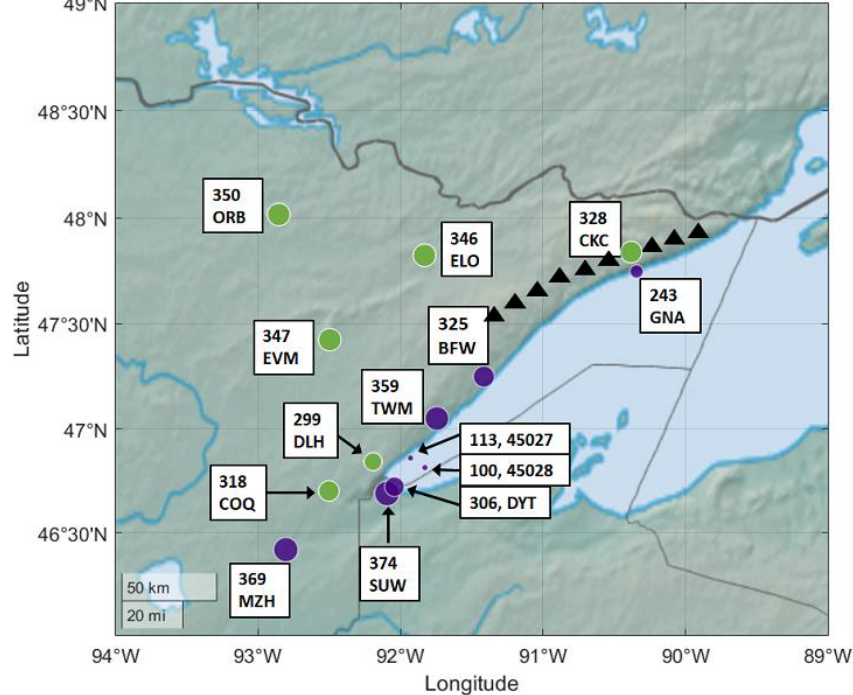
Figure 1. The study area in northeastern Minnesota. Blue dots indicate buoys and ASOS stations which are expected to experience a lake air mass influence, and green dots are ASOS stations not expected to experience this influence. Dots are sized according to total number of cold fronts observed at that station. The box next to each station indicates its identifier and the number of cold fronts that affected that station. Black triangles indicate the approximate location of the Sawtooth Mountains. Made with Natural Earth. Table 1. ASOS stations and buoy sites used in this study, with their name, latitude, longitude and altitude (m). Under the station name, ‘WI’ indicates that the location is in Wisconsin rather than Minnesota. ‘LI’ is used as an abbreviation for ‘lake influence’ in this table.